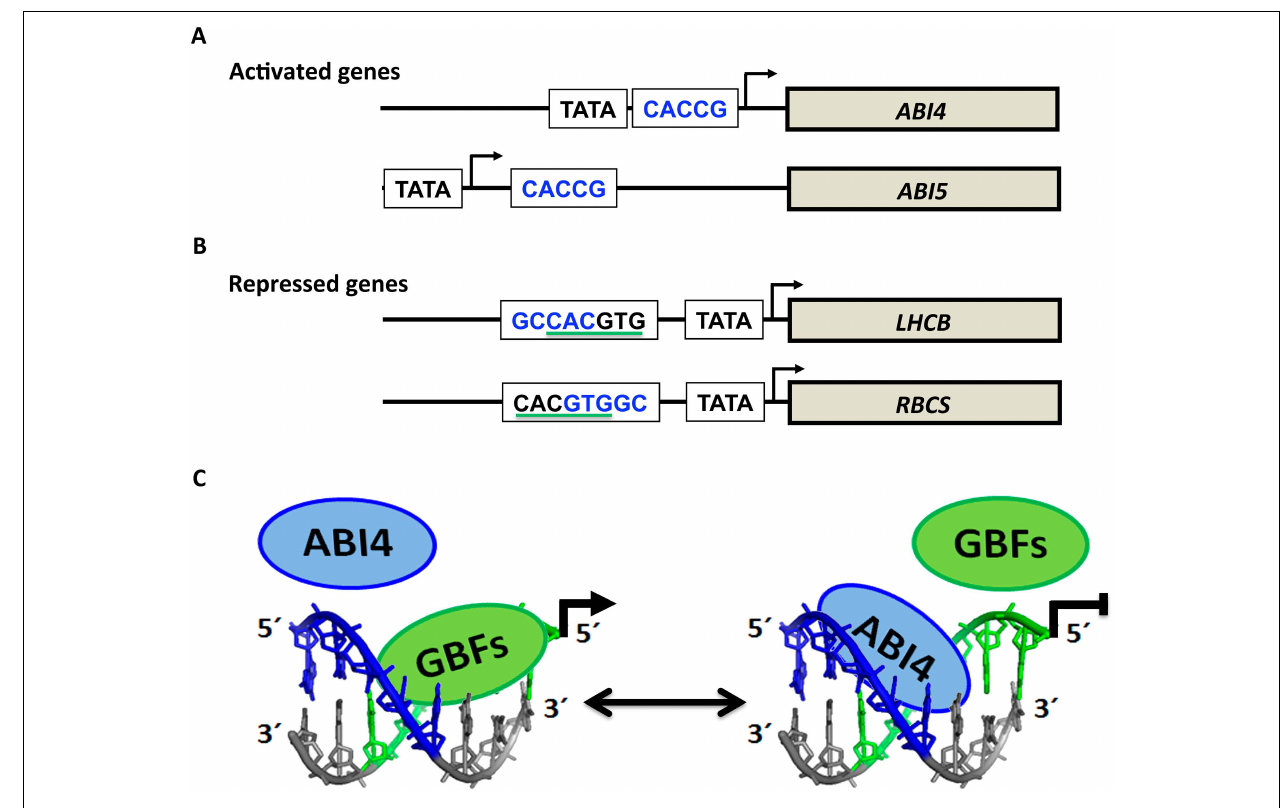
(G-box binding factor) results in non-activation of GBF target genes represented by the line in (C) . For ease of interpretation, the G-box is shown on the complementary-sense strand (green), whereas the CE1-like element (in blue) is depicted on the direct sense-strand.The GCCACGTG sequence was modeled by 3D-DART (Van Dijk and Bonvin, 2009) and visualized with PyMOL (http://www.pymol.org/).